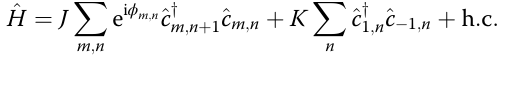
Hamiltonian 46,57,58 . Figure 2d presents the absorption image after 18 ms time of fl ight (TOF), in which the atomic populations in the different momentum states can be extracted directly. The TOF image in Fig. 2d is arranged to show the density distribution of atoms in the two-leg ladder in Fig. 2e, according to the connection of the atomic momenta to the synthetic lattice sites shown in Fig. 2b.